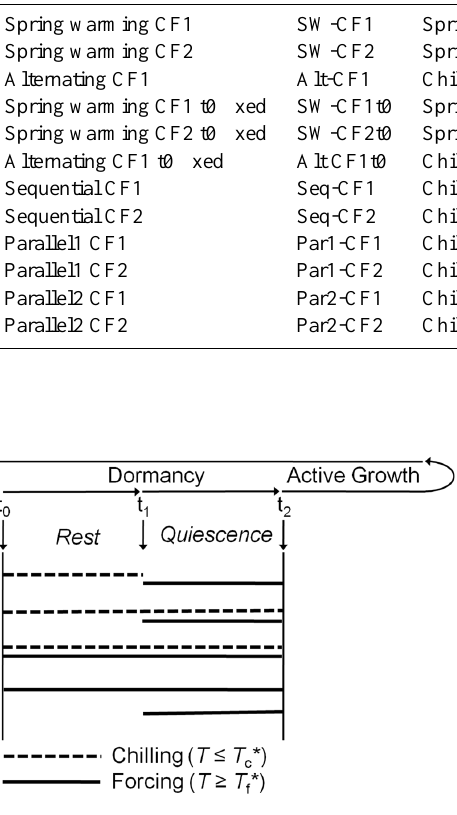
Fig. 2. Model representation of the seasonal cycle of terrestrial ecosystems, from senescence through dormancy (a period of rest, followed by quiescence) and then active growth. In temperate and boreal systems, the transition through dormancy to active growth has been described using a variety of approaches. Threshold points t 0 and t 1 may be triggered either by photoperiod or temperature (i.e. various forms of chilling: sequential, alternating or parallel, as indicated). At threshold point t 2 , bud-burst is triggered when ac- cumulated forcing reaches a critical state. The manner in which chilling and forcing accumulates varies among models. Chilling models describe phenology as a combination of temperature forc- ing, photoperiod limitation and chilling limitation; Spring warming models describe phenology as function of temperature forcing and photoperiod limitation (Table 2 for a list of model). Modified from Chuine